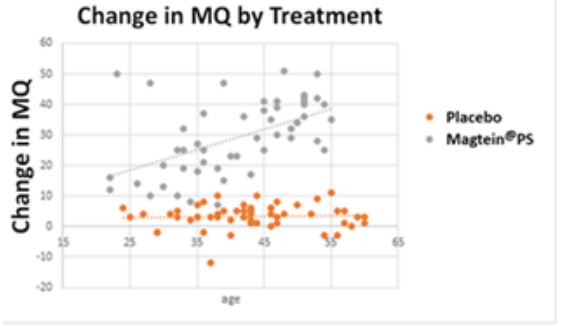
Figure 2. The effect of Magtein ® PS on MQ increases with age p value ( p < 0.001).